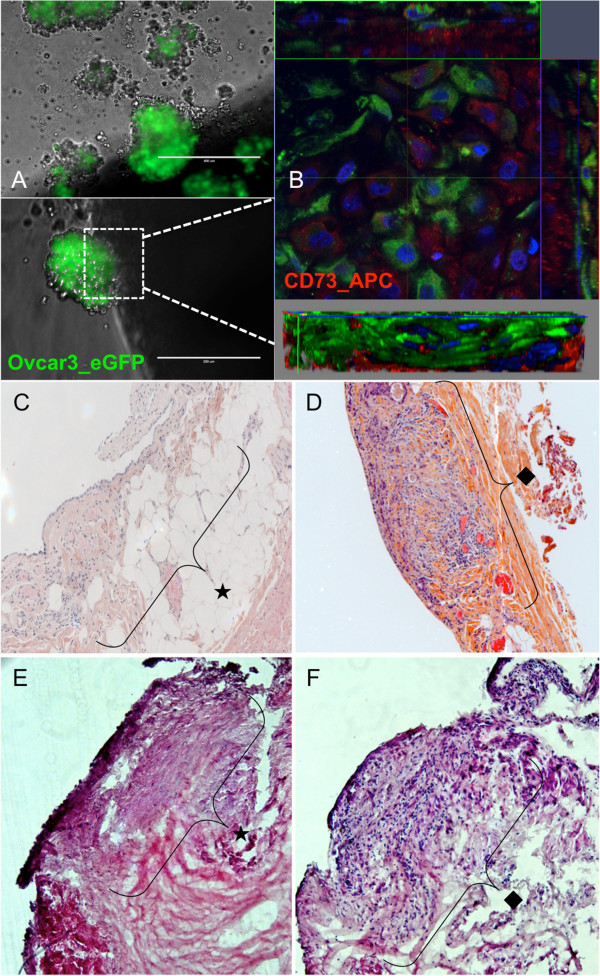
Amniochorionic membrane based 3D model: involvement of the amniochorionic membrane scaffold (AMS) by ovarian cancer cell lines compared to histologic involvement of the peritoneum. A. Picture by fluorescence microscopy of Ovcar3_eGFP aggregates after 24 hours 3D culture (upper picture). Early attachement (day 1) of the tumoral aggregates on AMS in fluorescence microscopy (lower picture). B. Early involvement of AMS stained with CD73 APC (red) by Ovcar3_eGFP (green) in confocal microscopy. On this Z-stack reconstruction of a small tumor, we could see the pattern of eGFP-OCC infiltration within the AMS. Amniotic stromal cells CD73+ were located in surface but also deeper within AM, surrounding OCCs. C-F. On the histologic sections stained with hematoxylin & eosin, the area below the mesothelium (star) of a normal peritoneum (C) and amniochorionic membrane (E) was free whereas it was filled with tumoral cells (rhombus) in sections of peritoneal metastasis (D) and involved AMS at day 2 (F).